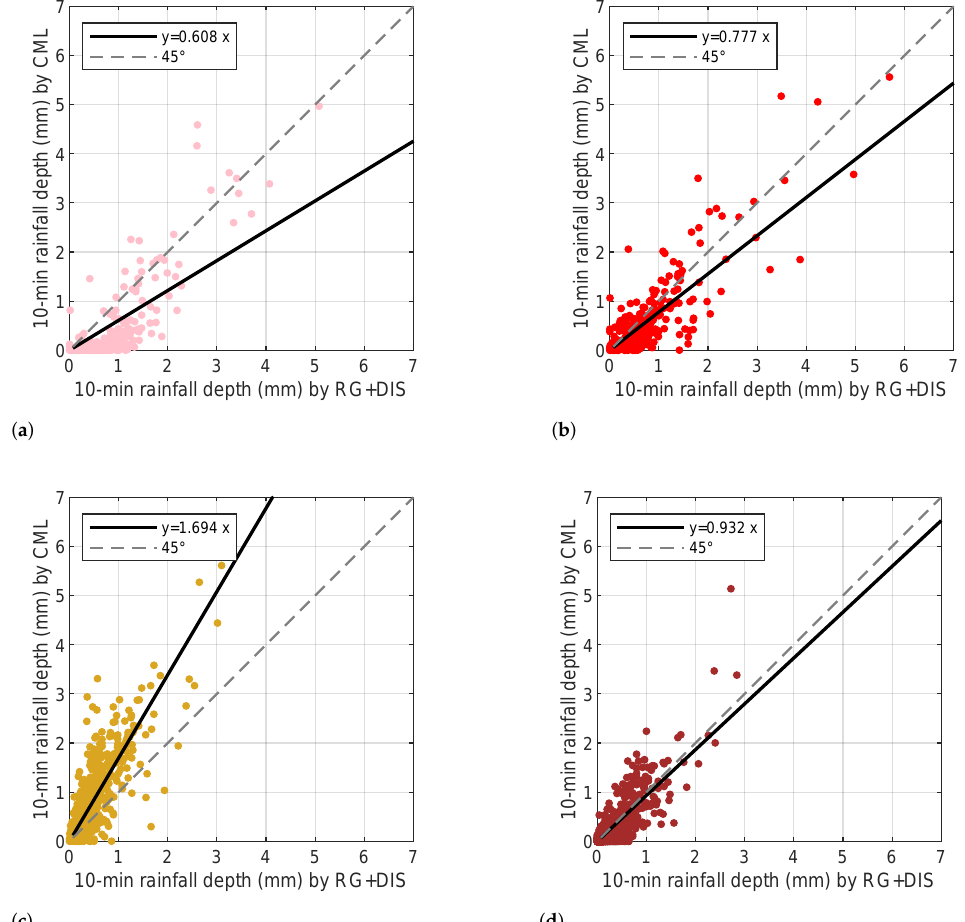
Figure 9. Scatterplots between CML-based and (RG+DIS)-based 10 min rainfall depth estimates: ( a ) CML 9, ( b ) CML 10, ( c ) CML 11, and ( d ) CML 13. Rainfall depths values below R min were filtered out before calculating the best